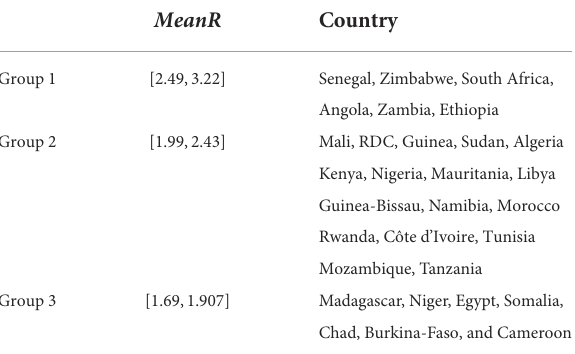
TABLE 1 Distribution of MeanR by